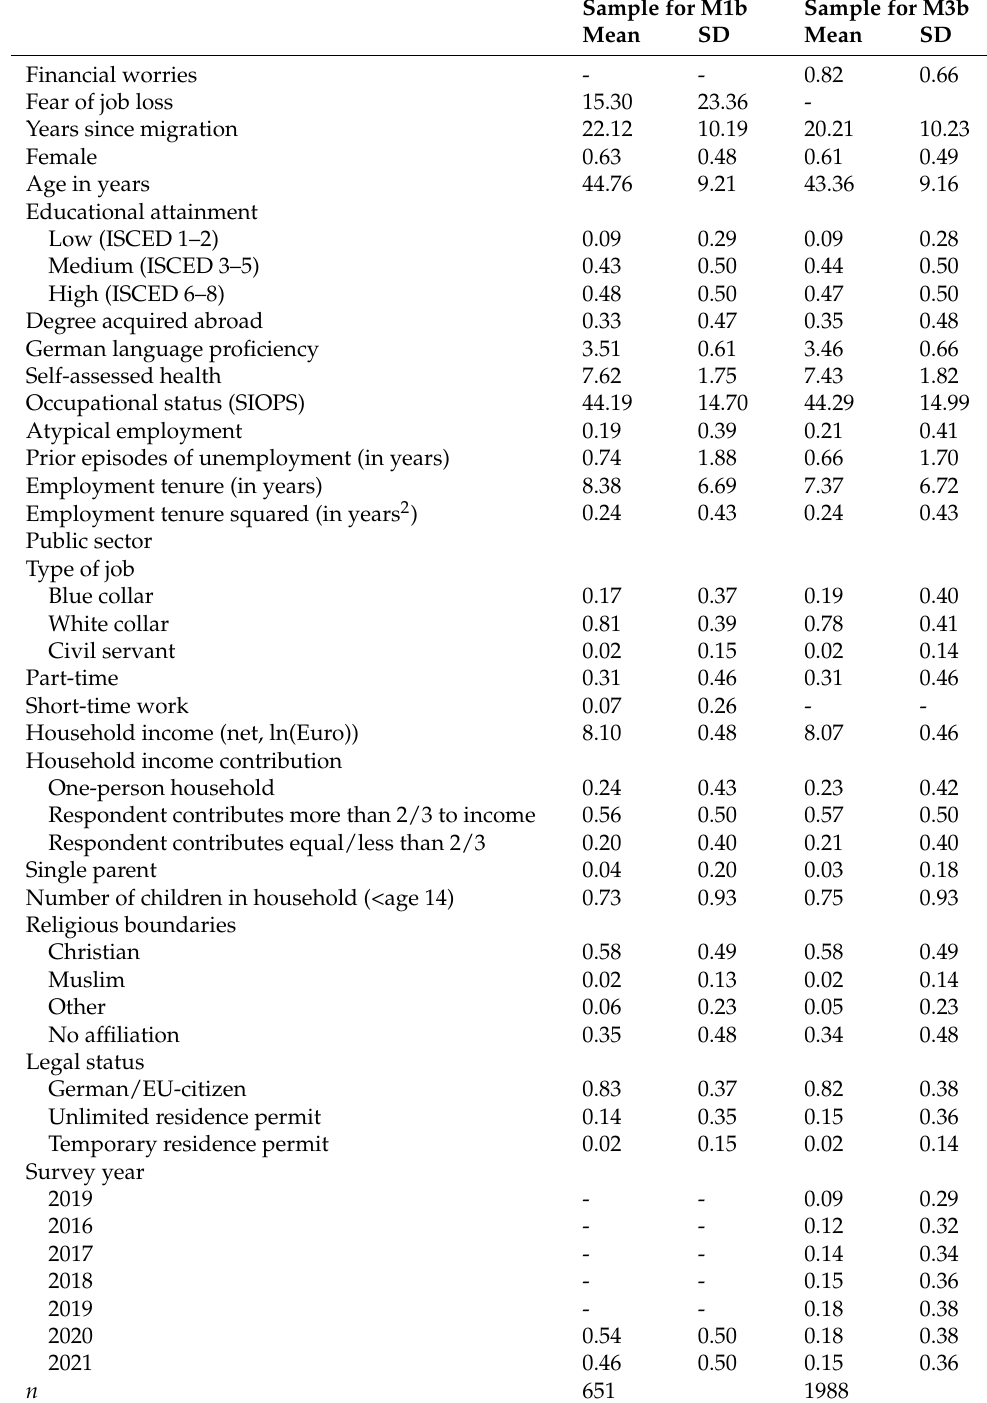
Table A2. Descriptive statistics, first